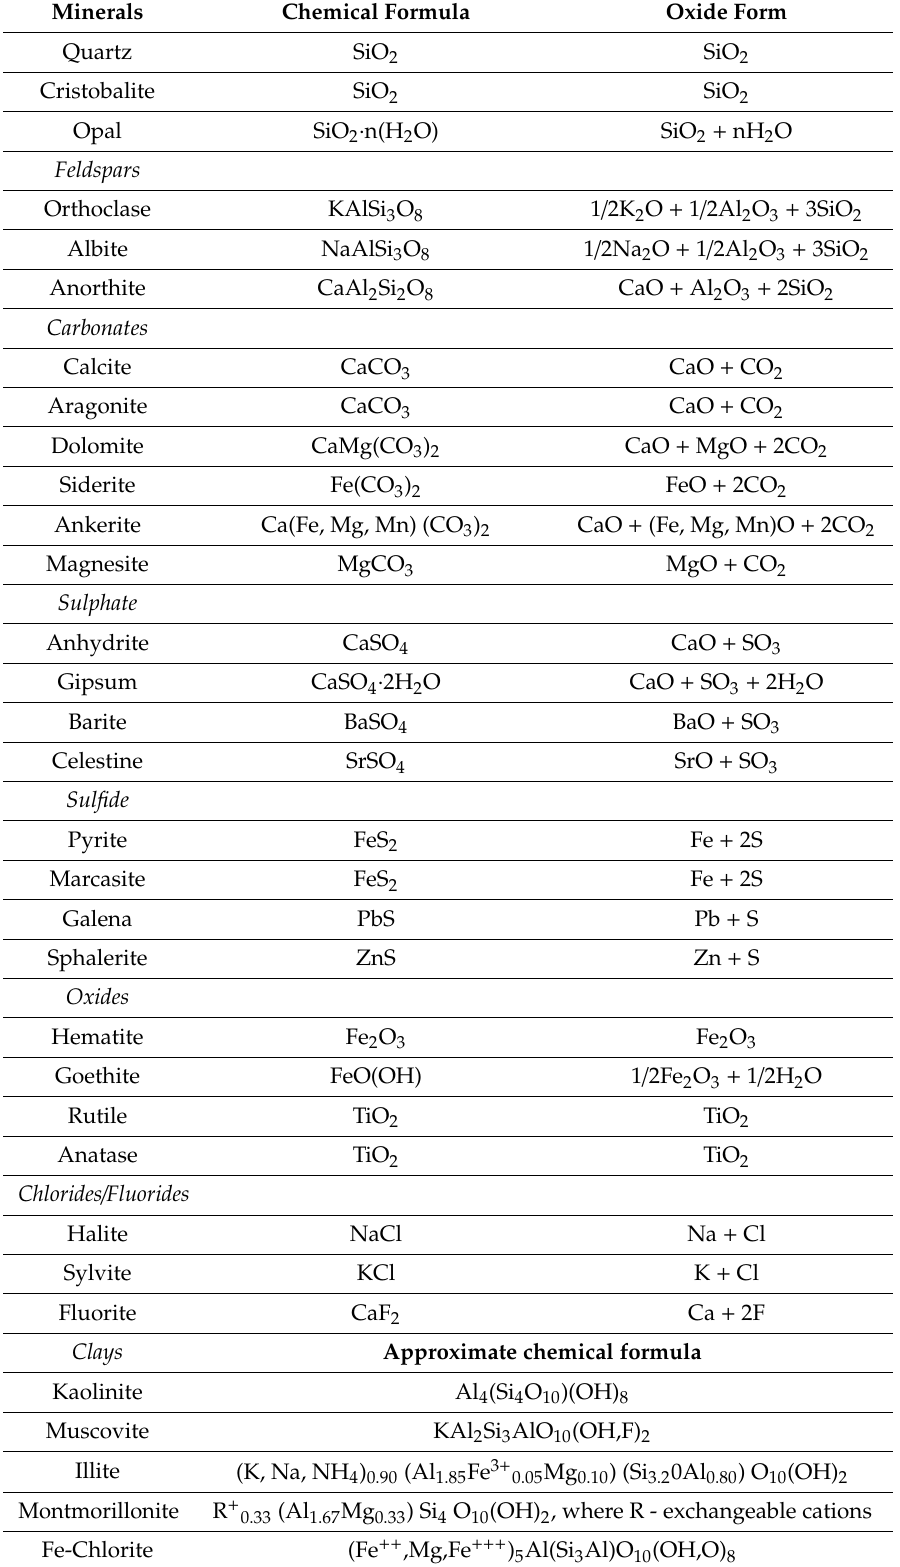
Table 1. List of minerals occurring in sedimentary basins most frequently analysed for the purpose of hydrocarbon exploration in Poland. For minerals marked red, the oxide form of record cannot be